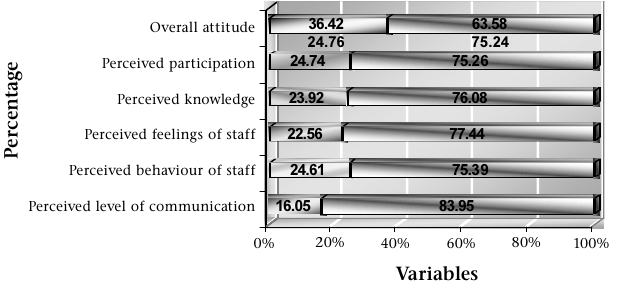
Figure 1: Impact of the variables on the change